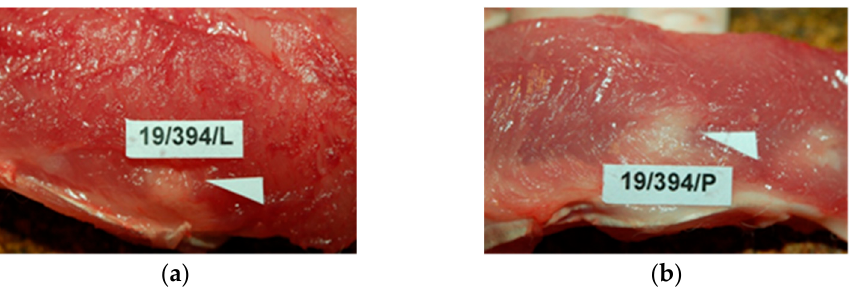
Figure 5. Macroscopic view of: ( a )—the tested PACVD-modified sample and ( b )—after 12 weeks of intramuscular implantation (implants are marked by arrows.